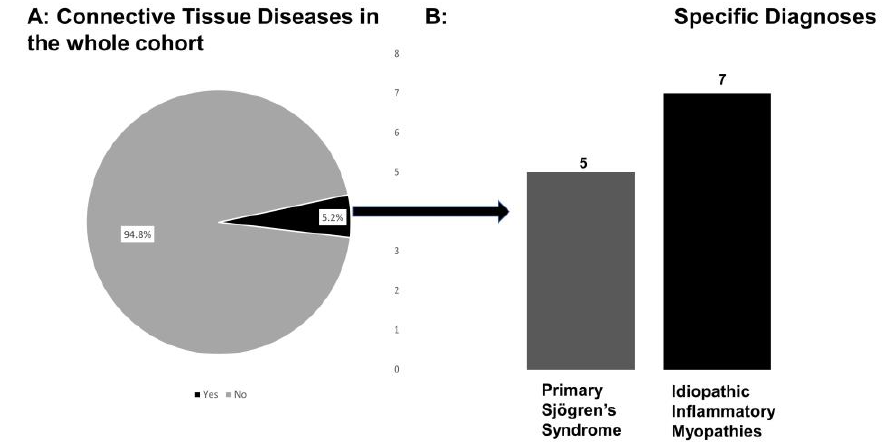
Figure 1. Legend: ( A ): Proportion of Connective Tissue Disease (CTD) in the whole cohort (reported in proportion); ( B ): Specific diagnoses made in the patients with an underlying or that developed a CTD in the cohort.